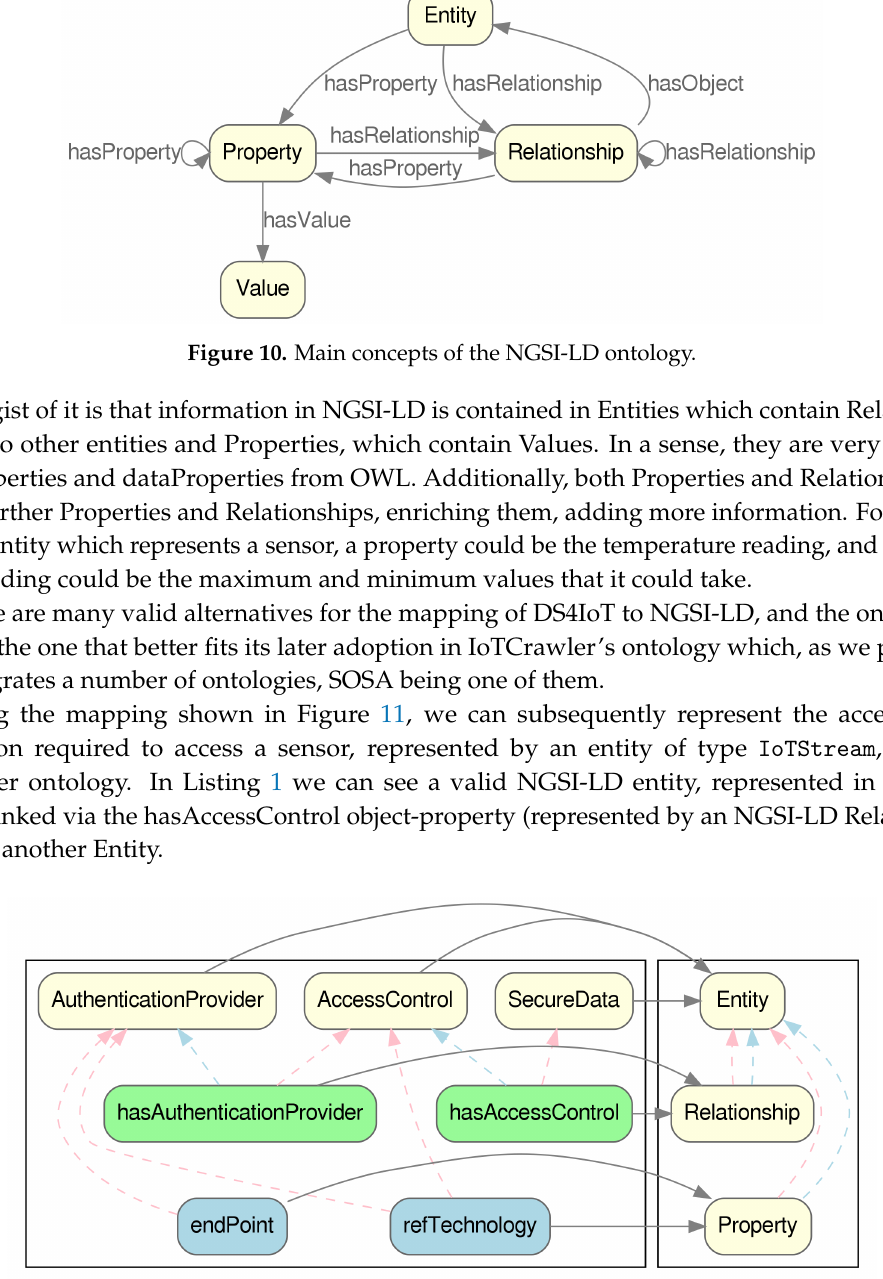
Figure 11. Conceptual mapping between ( a ) DS4IoT and ( b ) NGSI-LD. Classes in light yellow, object properties in light green and data properties in light blue. In dashed red and blue lines the domain and range, and in grey lines, the mapping between